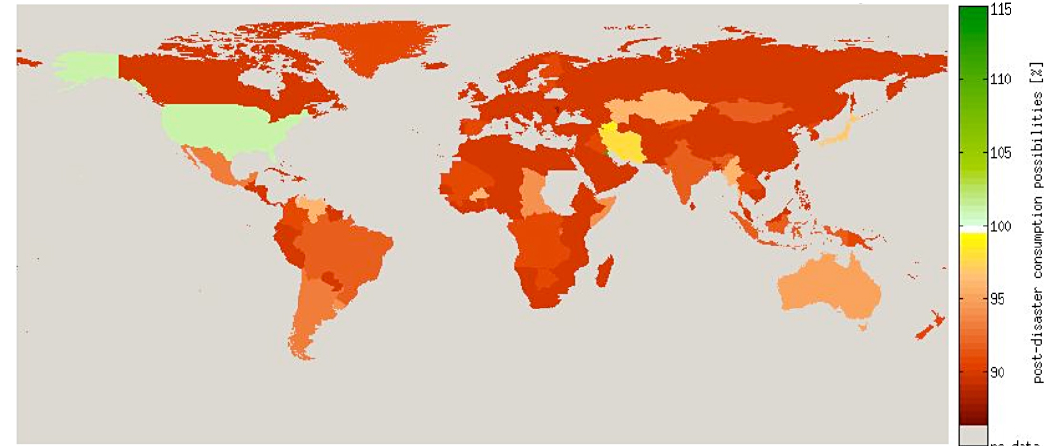
Figure 4. Storm scenario 2: a Quebec-like event centered over Europe. Due to Europe’s participation in many global supply chains, a disaster in Europe would be felt not just in the continent itself, but in nearly all other countries in the world as well. The US is a notable exception: their economy could experience a slight increase in consumption possibilities in the post-disaster economy.